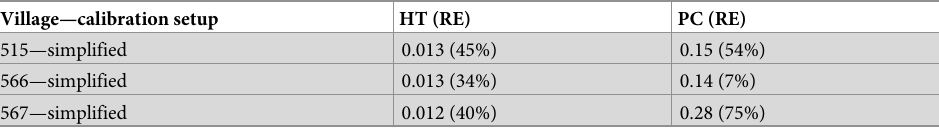
Values of simulated HT and PC prevalence for simplified ABC setup with RE. The simulated values are the product of simulations run using the minimum ABC distance parameter sets for the third calibration stage. The Relative Errors (RE) is defined as: |Prev obs -Prev sim |/Prev obs . The REs are calculated using observed data from Table 5.